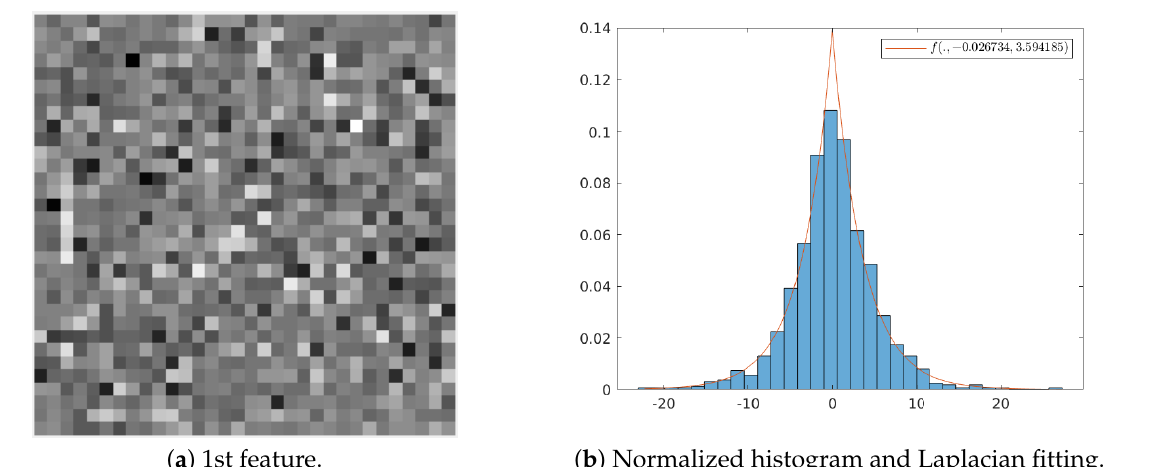
Figure 3. First feature of Cannes image representation, its normalized histogram with Laplacian